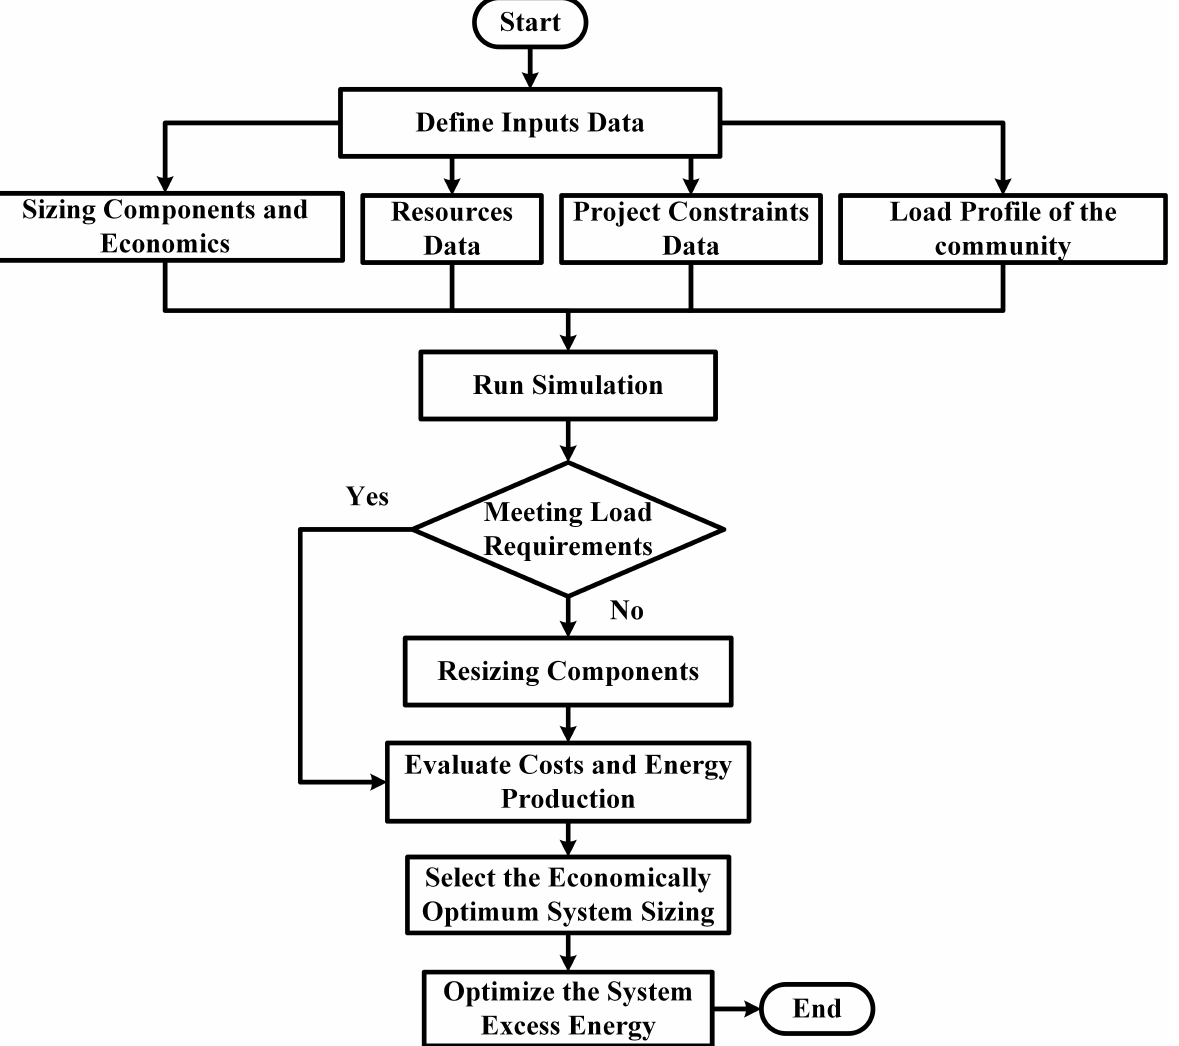
Figure 4. Characterization flow of the reliability process of the hybrid energy system in terms of COE, NPC, and other objectives